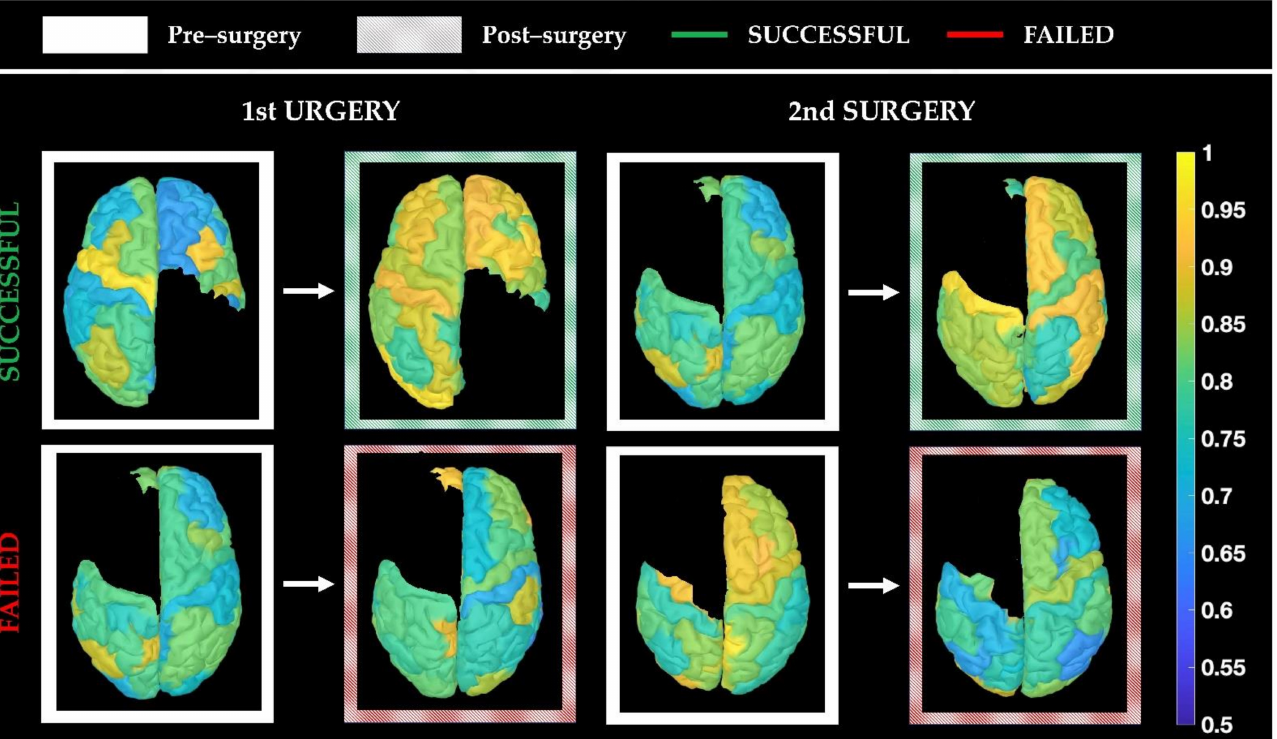
Figure 6. Examples of post-surgical global centrality changes in the theta band. Examples of post-surgical changes in global centrality, showing one patient image from the seizure-free group (patient 16, top left ) and three from the repeated surgery group (patient 2, bottom left and top right ; patient 4, bottom right ). Each cortical ROI (that was not touched during surgery) is color-coded based on its global centrality value, whereby yellow indicates a high level of connectivity and blue indicates a low level of connectivity. In the successful surgery examples ( top row ), the color maps show an overall increase in post-surgical connectivity. On the other hand, in the examples of first and second failed surgeries, the color maps show no changes or decreases in